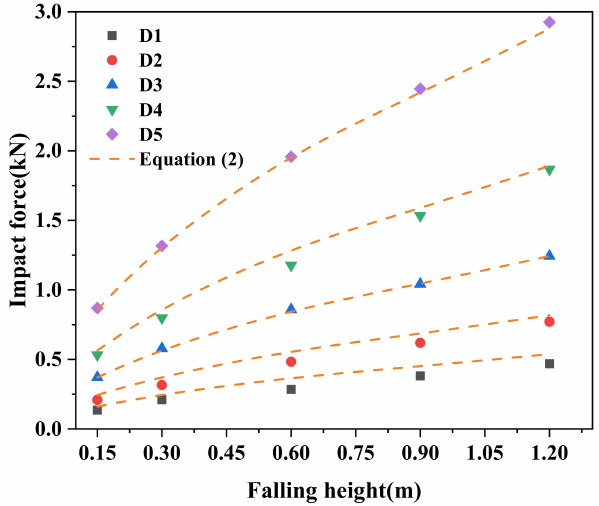
Figure 6. Comparison between fitting results and test